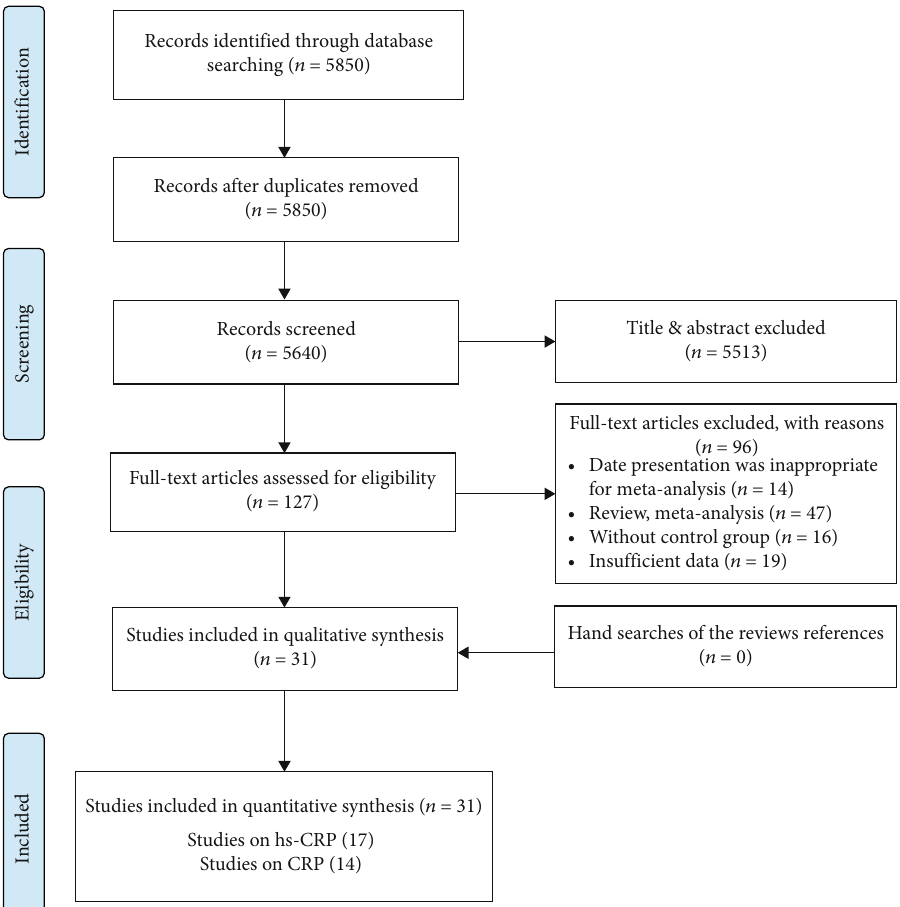
Figure 1: PRISMA fl ow diagram of the study selection